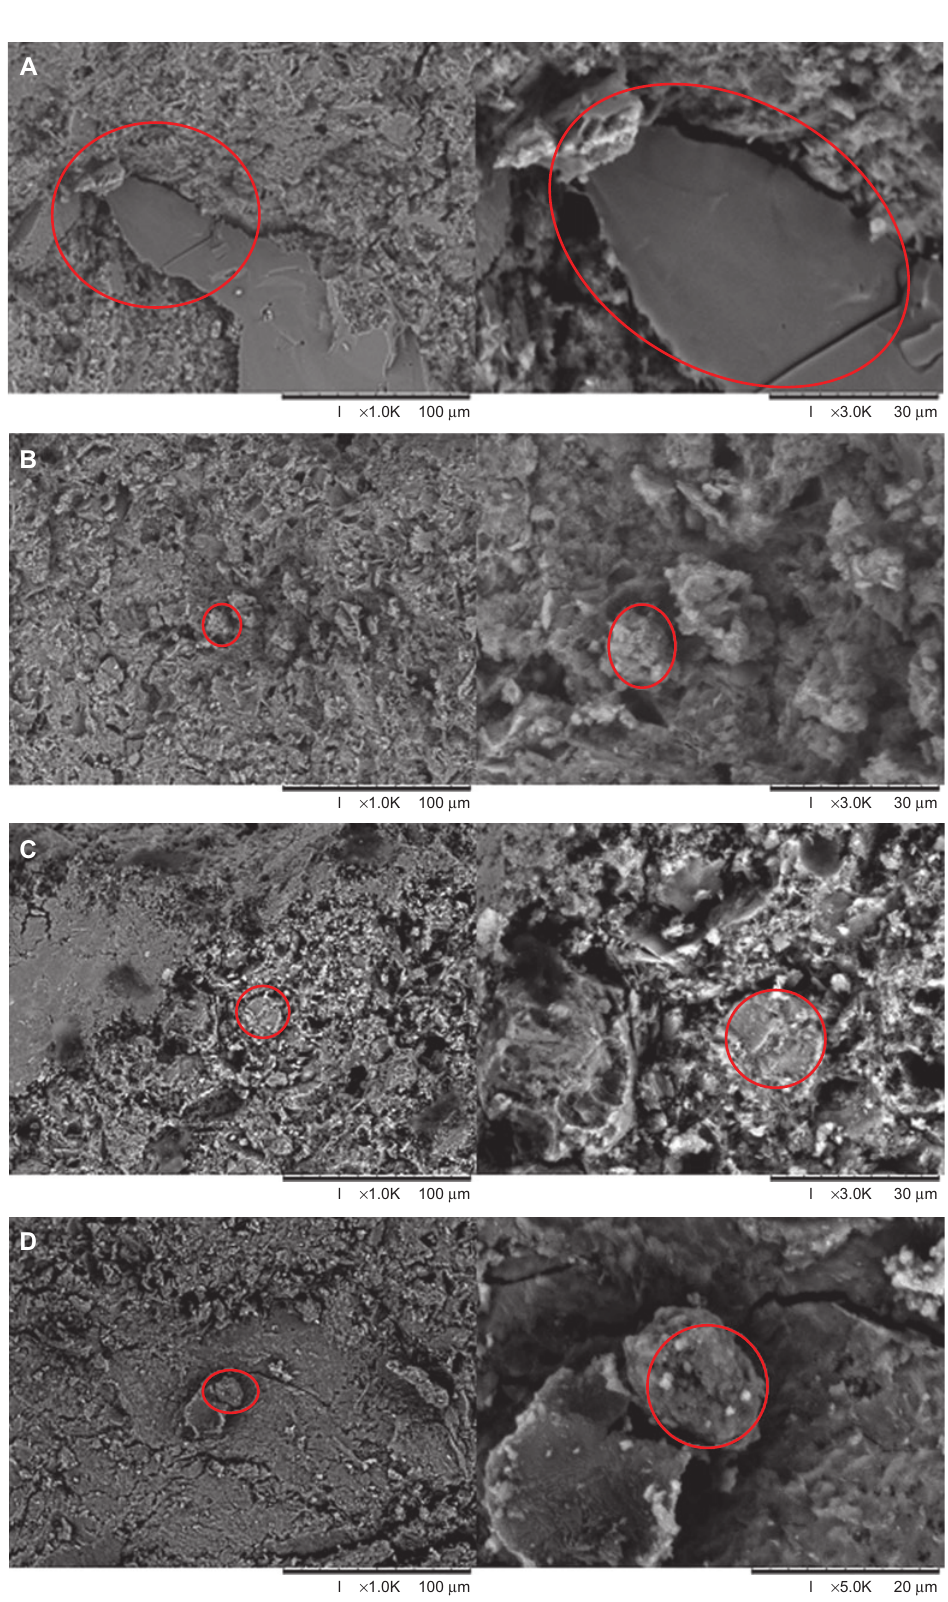
Figure 11 (A) SEM micrograph of cement mortar without montmorillonite at 1K and 3K x; (B) SEM micrograph of cement mortar with 5 % montmorillonite at 1K and 3K x; (C) SEM micrograph of cement mortar with 10 % montmorillonite at 1K and 3K x; (D) SEM micrograph of cement mortar with 15 % montmorillonite at 1K and 3K